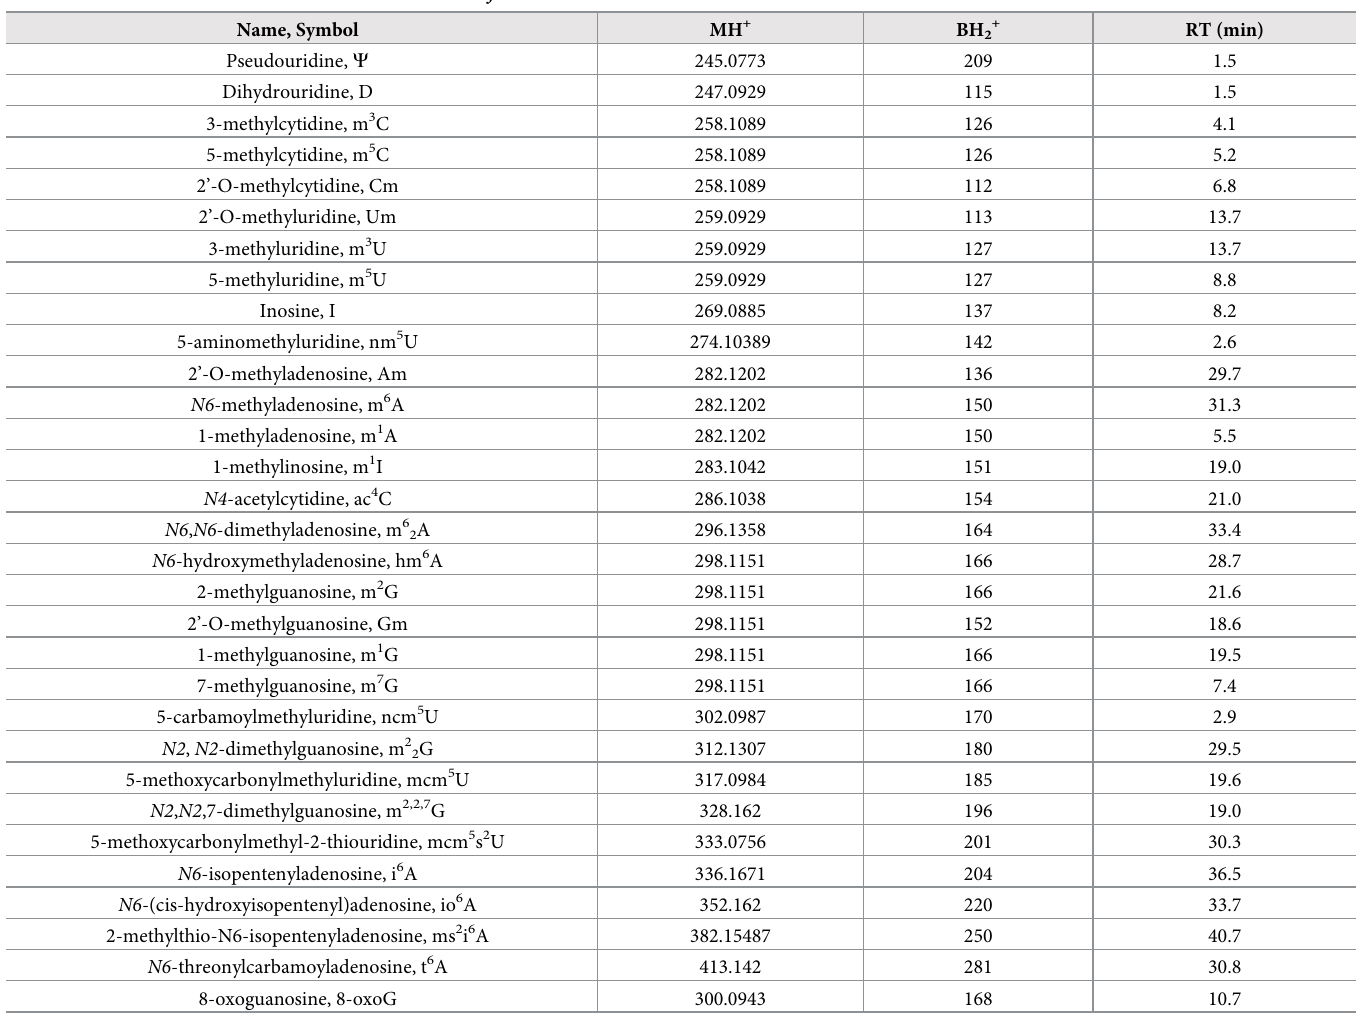
Table 1. The modified RNA nucleosides detected in C . neoformans